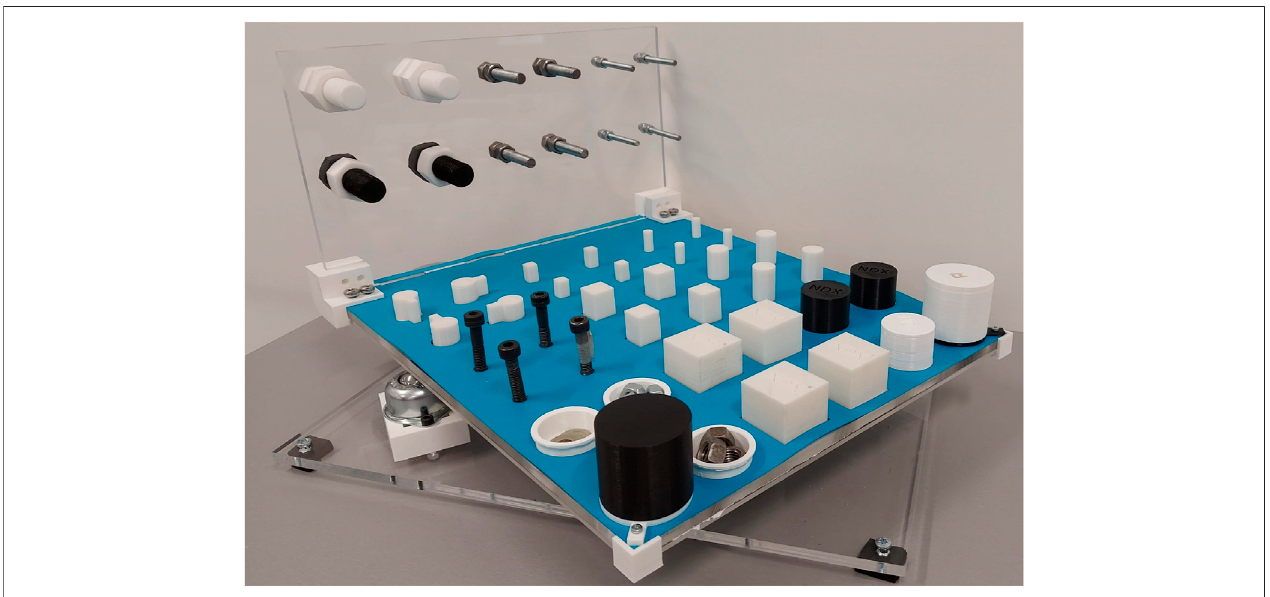
FIGURE1| Prototypeoftheproposeddexteritytestboardthatisequippedwitharotatingbasemechanism.Theboardisdevelopedusingplasticpartsthatare3D printed and acrylic parts that are fabricated using laser cutting.